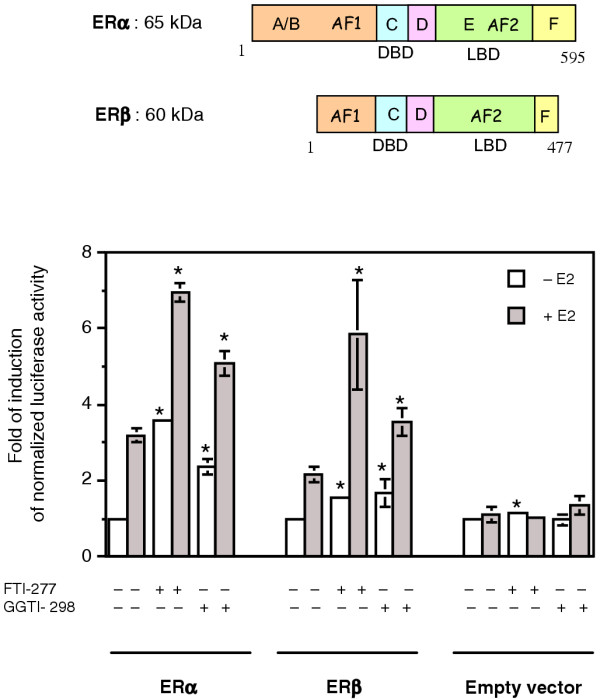
Effects of prenyltransferase inhibitors on estrogen response element-dependent luciferase activity in HELN cells transfected with estrogen receptor (ER) α or ERβ. Cells, deprived of estradiol (E2) for 4 days, were co-transfected with the Renilla luciferase plasmid and either HEG0 (full-length ERα), pSG5-REβ (full-length ERβ) or pSG5 (empty vector). Five hours after transfection, cells were treated or not with FTI-277 (10 μM or dithiothreitol/dimethylsulfoxide vehicle), and 24 hours later they were stimulated with E2 (5 nM) or ethanol and were treated or not with FTI-277 or GGTI-298 (10 μM or 5 μM, respectively, or dithiothreitol/dimethylsulfoxide vehicle). Luciferase activity was quantified 16 hours after E2 addition, as described in Materials and methods. Results are expressed in arbitrary units after normalization. Error bars indicate the mean values ± standard deviation from triplicate experiments, and the results are representative of three independent experiments. Results obtained show that prenylation inhibitors statistically increase the luciferase activity on their own compared with control cells (white bars) and statistically increase the luciferase activity induced by E2 compared with the activity induced by E2 alone (grey bars) in MELN cells transfected with ERα or ERβ (* P < 0.05).